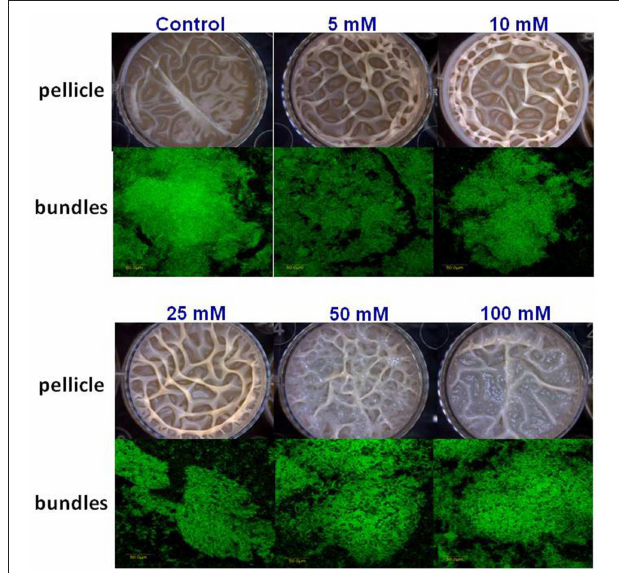
FIGURE 5 | The effect of Ca 2 + ions on biofilm formation by B. subtilis . The effect of addition of different concentrations of CaCl 2 to LBGM medium on pellicle formation by B. subtilis